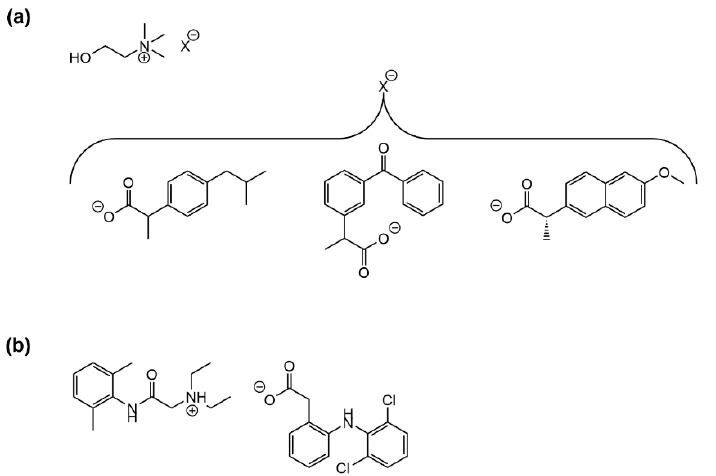
Figure 10. Examples of NSAIDs-derived ILs advanced for transdermal delivery: ( a ) ILs produced by pairing the cholinium cation with the anionic forms of (from left to right) ibuprofen, ketoprofen, and ( S )-naproxen [135]. Adapted with permission from ref. [135]. Copyright 2019 American Chemical Society; ( b ) dual-action IL composed by the cationic form (conjugate acid) of lidocaine and the anionic form (conjugate base) of diclofenac [136]. Adapted with permission from ref. [136]. Copyright 2020 Springer Nature.